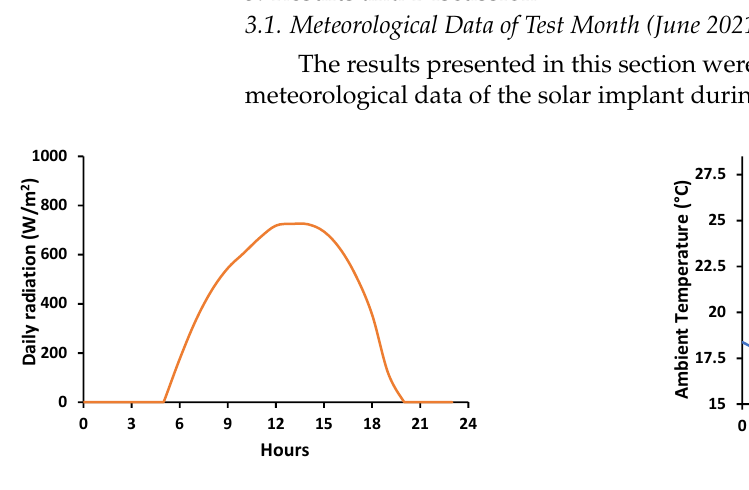
Figure 7. Average of daily radiation ( left ) and ambient temperature ( right ) of the location of the solar implant during June 2021.